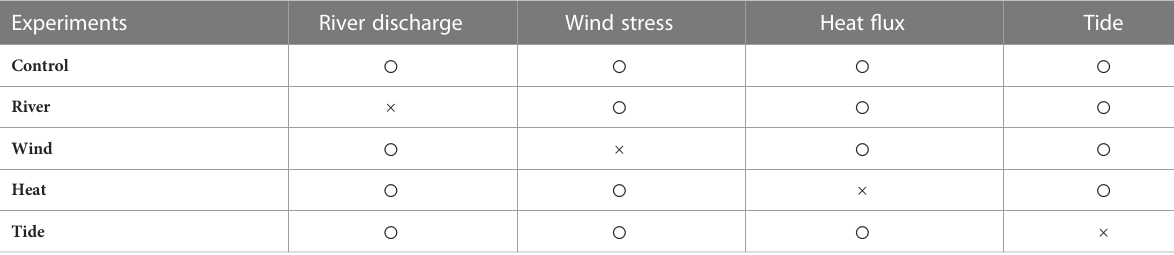
TABLE 1 External factors considered in each